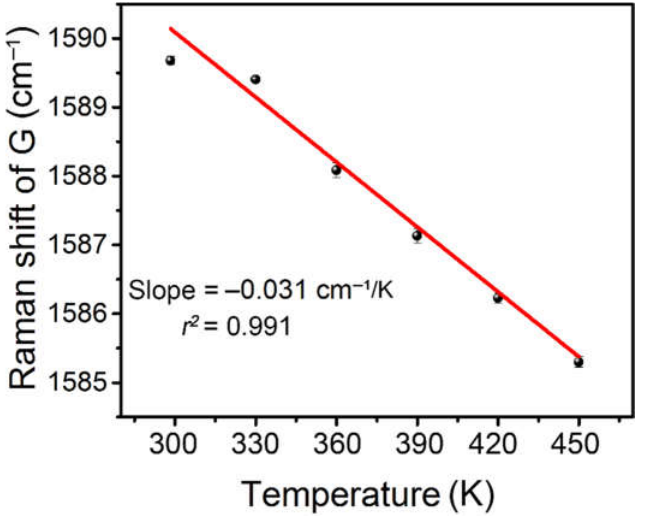
Figure 1. Raman shift of G + peak as a function of the temperature for CNT films.